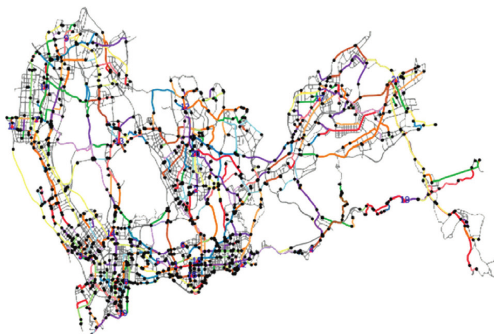
Figure 14: Planned path after optimization.